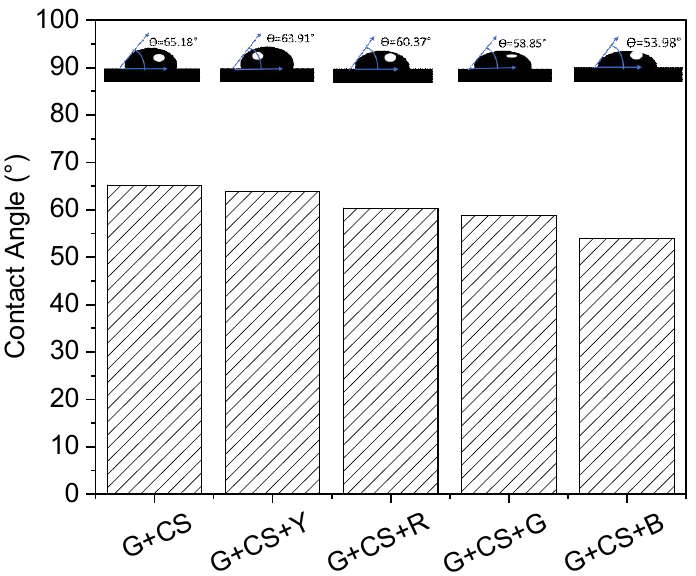
Figure 5. CA (contact angle) image of different concentrations of food color in gelatin–cornstarch- based edible films.